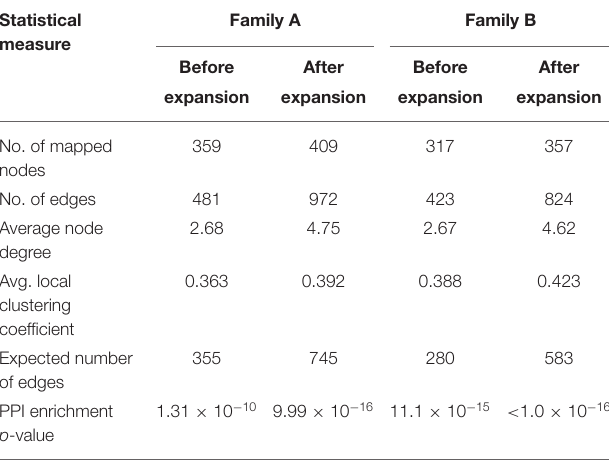
TABLE 1 | Statistical parameters of original and expanded WES–GWAS protein networks generated by STRING database.